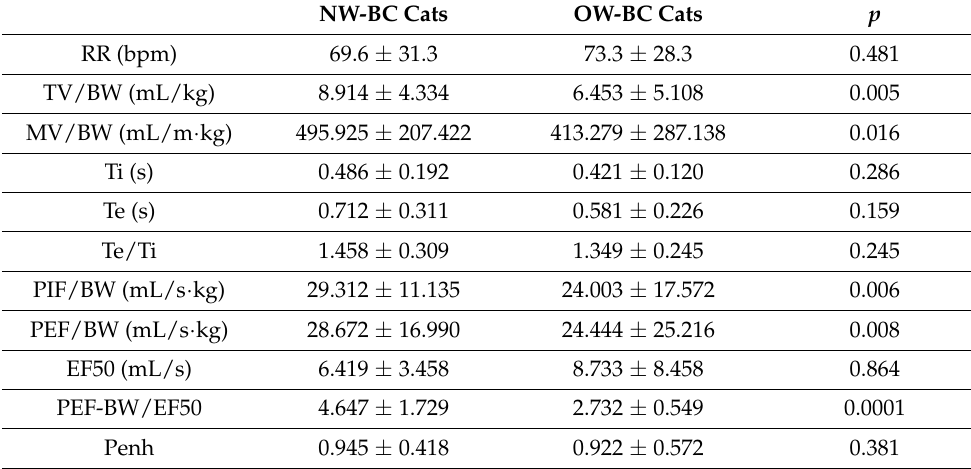
Table 2. Pulmonary lung function variables determined in each group. It was observed that all the variables with statistically significant differences had a lower value in OW-BC